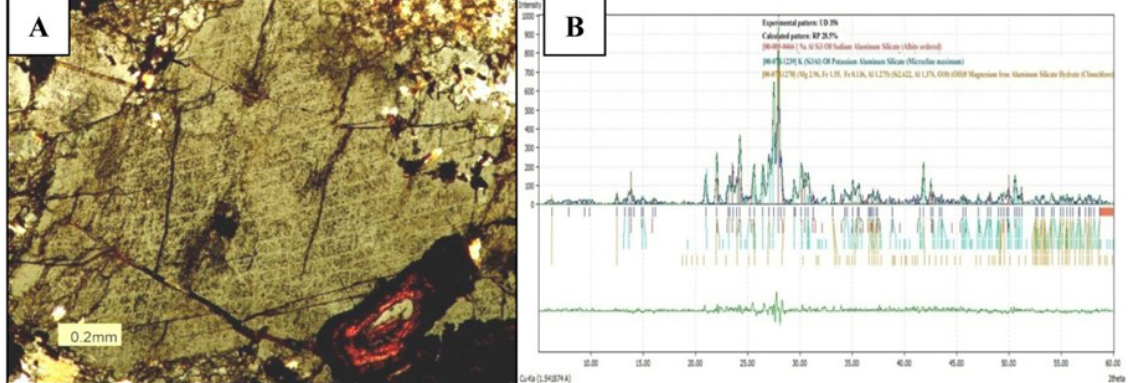
Fig. 7. Highly ordered cross-hatching microcline in alkaline rocks. A. Microcline and zoned goethite (cross polarized transmitted light). B. Quantitative XRD analysis of metasomatic rocks (albite, microcline)